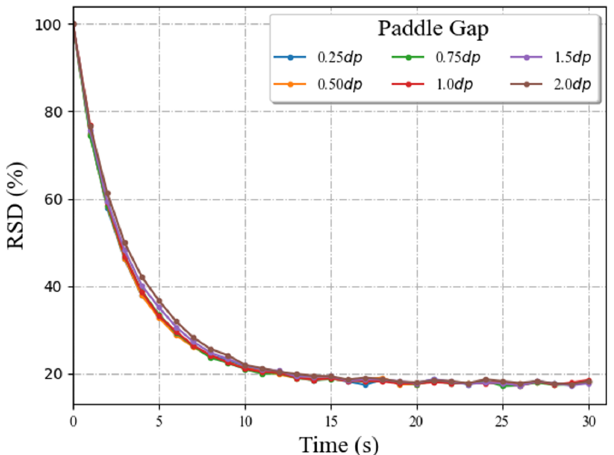
Figure 10. RSD values versus time for various paddle gaps for 40 RPM, 40 % fill level and 0° paddle angle.